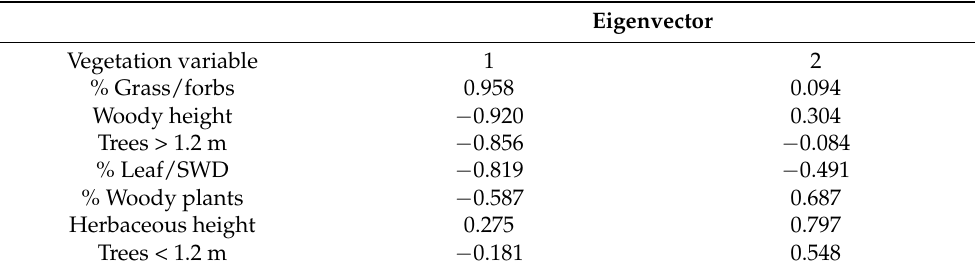
(Figure 4; Supplementary Table S1). In the mixed-effects model, “treatment” (fixed effect) explained 23% of the variance in the number of active burrow openings, while “site” (random effect) explained another 27%, as indicated by the pseudo-R 2 values. Estimated least-squares means indicated that the frequently burned and mechanical treatments had more burrow openings than the infrequently managed treatments (Table 3; Figure 4 inset); unadjusted p -values from Tukey’s test were <0.10 for comparisons of the infrequently burned treatment to both frequently burned and mechanical treatments. However, the Sidak adjustment increased the p -values to >0.15 (Table